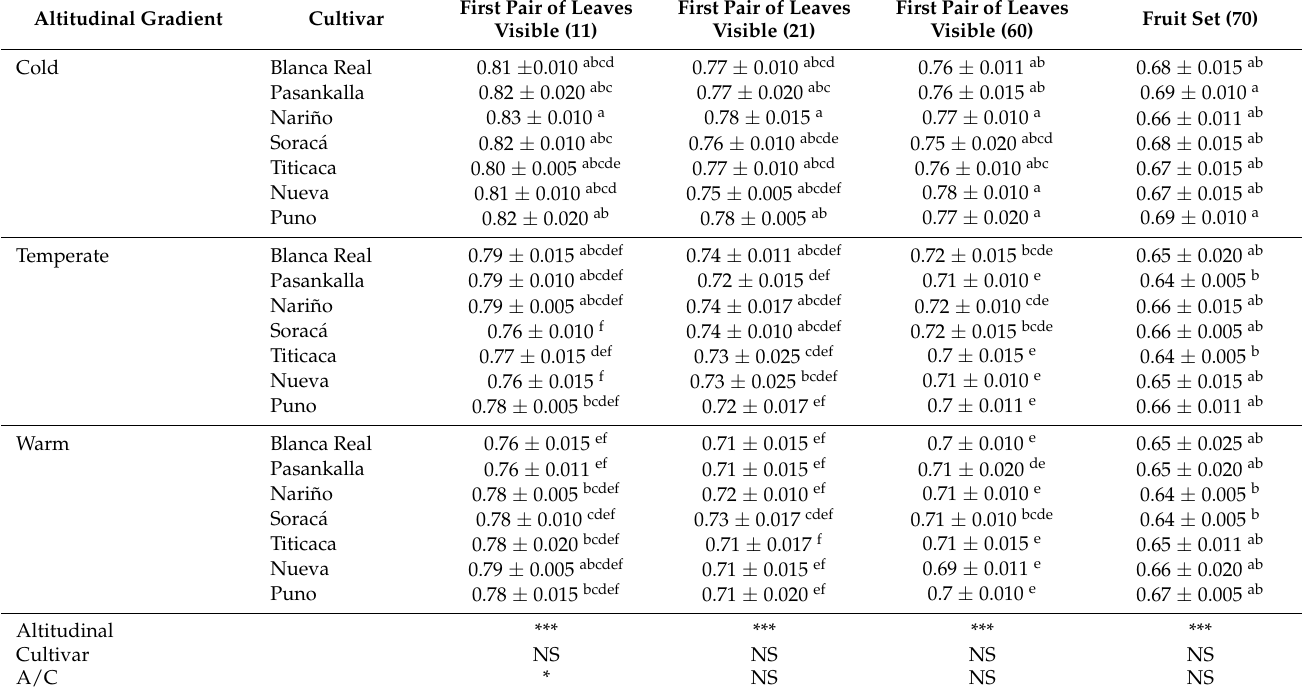
Altitudinal Gradient Cultivar